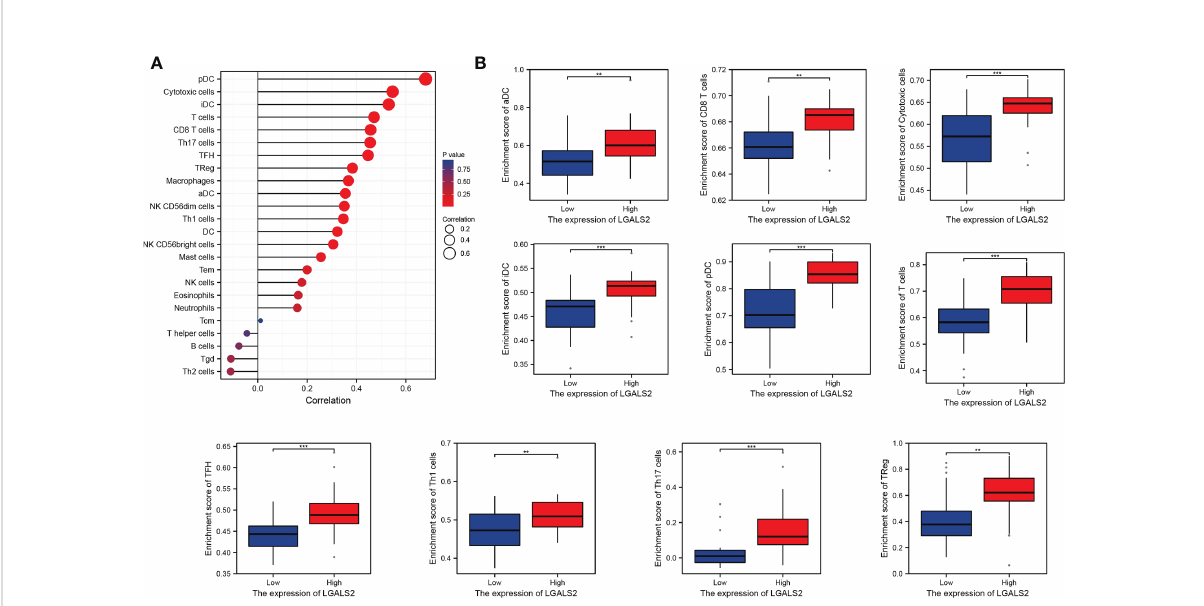
FIGURE 6 Distribution of immune cell in fi ltration in DLBCL. (A) Relationship of LGALS2 expression and immune cell subtypes in DLBCL patients; (B) Bar plot of LGALS2 expression and immune cell subtypes. ** P < 0.01, *** P < 0.001.